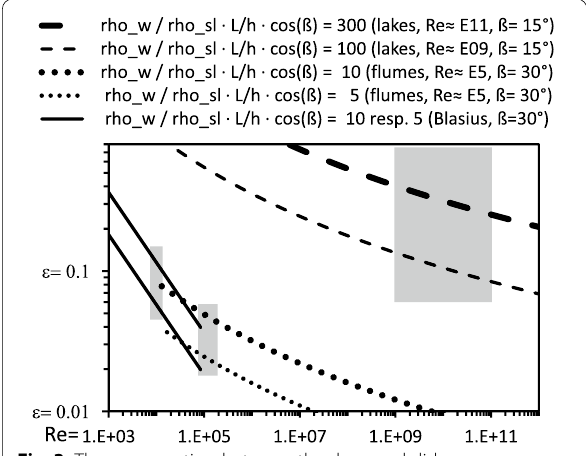
Fig. 3 The energy ratio ε between the shear and slide energy, ε E sh / E sl , as a function of the shear Reynolds number for different = values of ρ w /ρ sl L / h cos(ß). The shadowed areas indicate the · · domains of lakes, ~ 10 9 < Re < ~ 10 11 , of flumes, Re ~ 10 5 , and of miniature models (Blasius, 1908), Re ~ 10 4 . ε is low for flumes